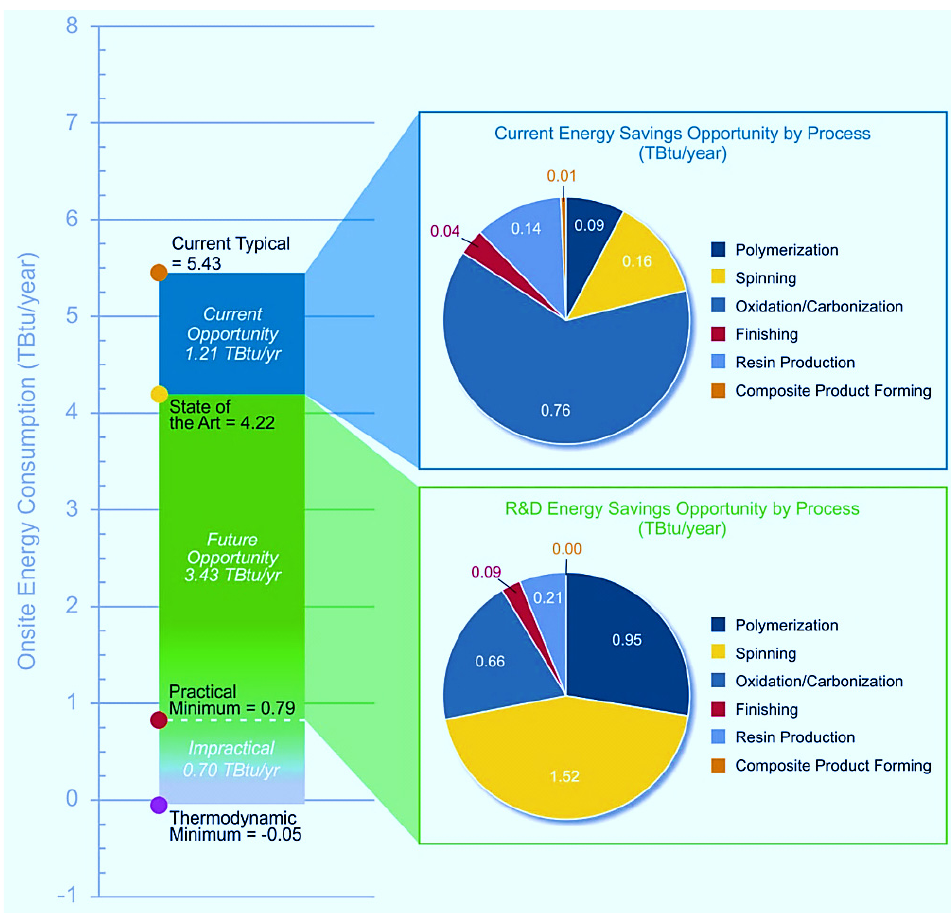
Figure 17. Opportunities for energy savings in manufacturing of CFRP composite [redrawn from reference [149]]. reference